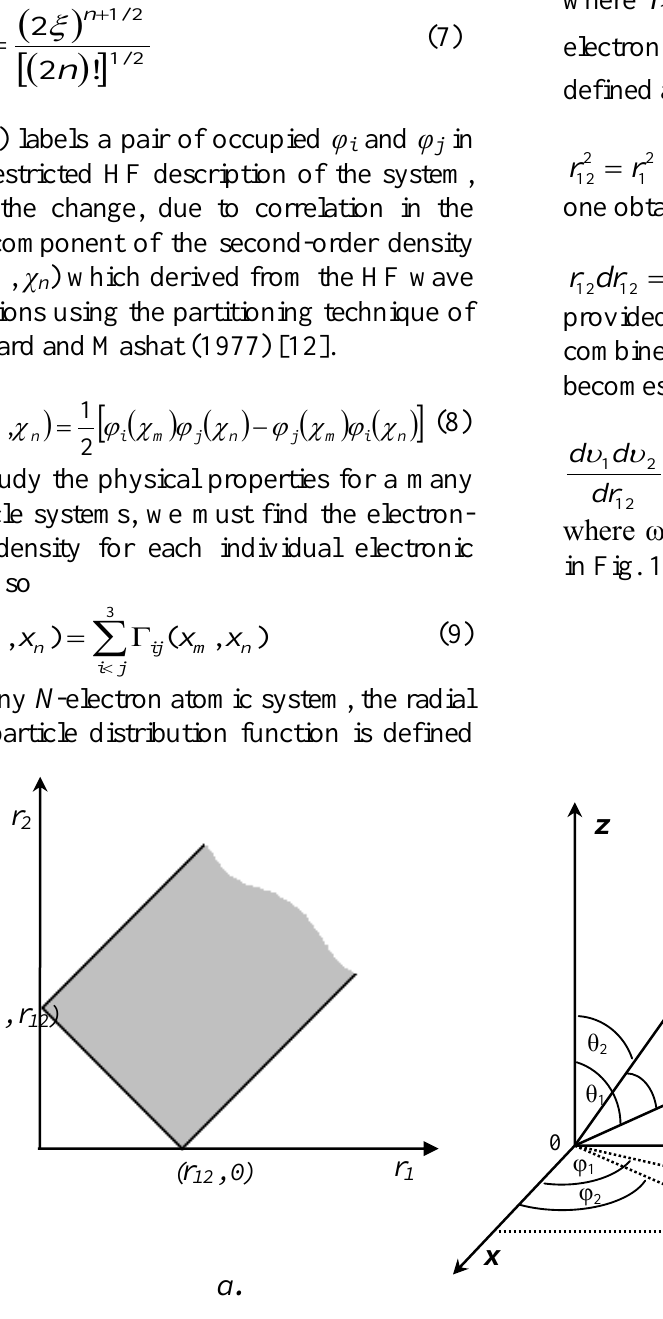
Fig. 1: a. The radial integration range in Equ.(3.10) is represented by the shaded area. b. Coordinate system involved in the determination of f(r